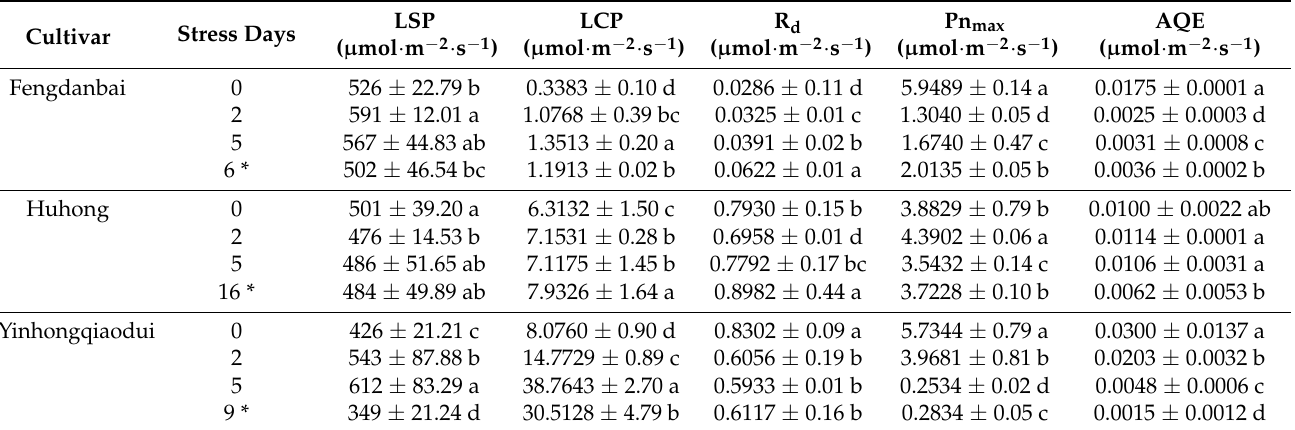
Table 3. Effect of high-temperature stress on the characteristic parameters of light–response curves of Fengdanbai’ ‘Yinhongqiaodui’ and ‘Huhong cultivars of peony leaves.